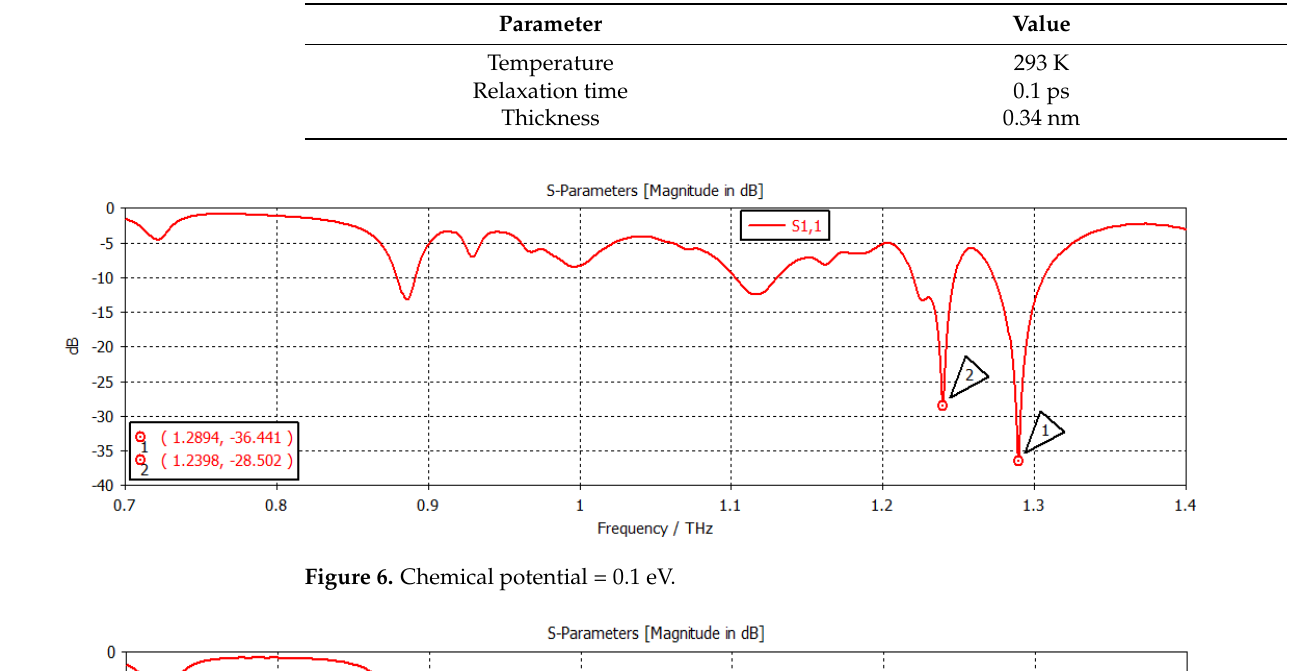
Figure 5. Impedance plot. Table 2. Graphene parameters.